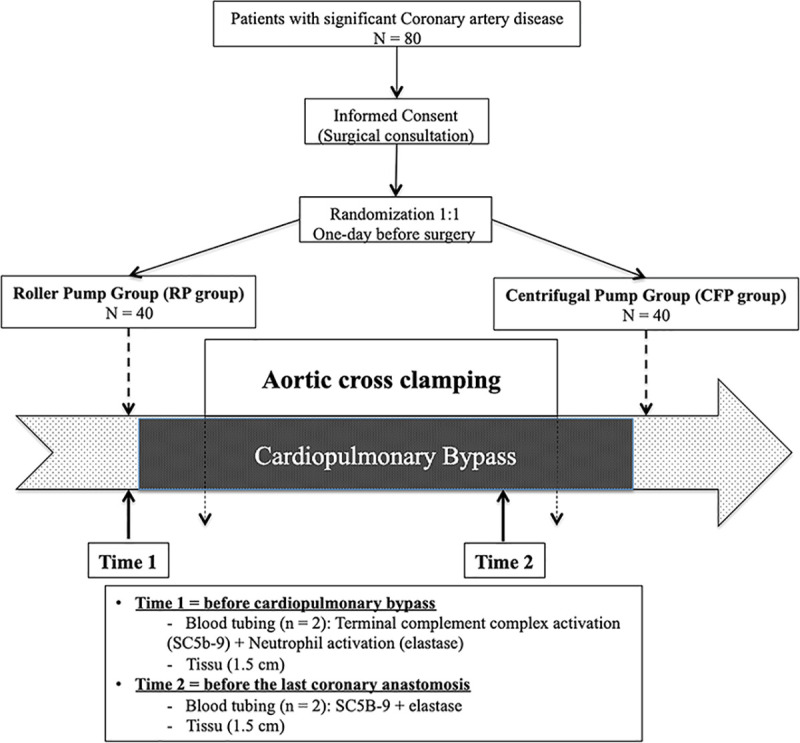
Flow-chart study.